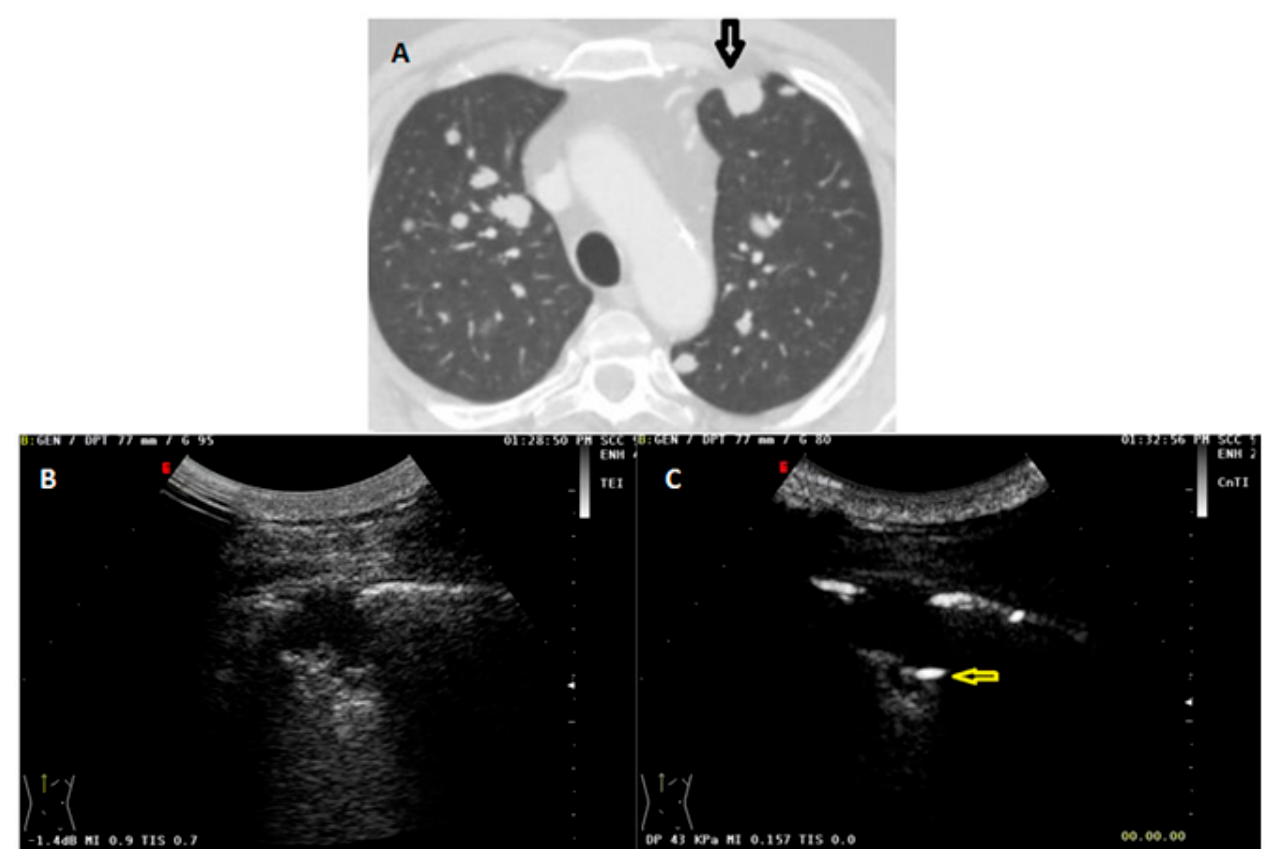
Figure 5. ( A ) Axial chest CT scan (lung window) showing a subpleural malignant pulmonary lesion in the anterior segment of the left upper lobe (black arrow). ( B ) The corresponding US B-mode scan showed a subpleural hypoechoic lesion with a hyperechoic spot within. ( C ) In the US scan with contrast setting (mechanical index: 0.157), but without the administration of contrast agent, seems to be even enhanced (yellow arrow).